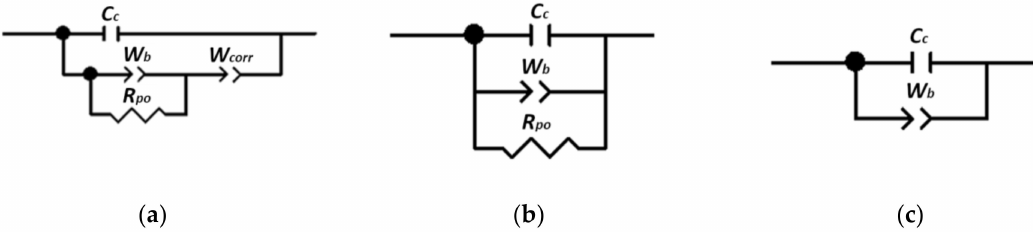
Figure 1. Equivalent circuits used for analysis of EIS data (models a , b and c ). C c , W b , R po and W corr , represent the coating capacitance, the Warburg di ff usion through the coating, the resistance of conductive paths through the electrolyte-filled coating pores and the Warburg coe ffi cient for a di ff usion-controlled corrosion process (see Equations (1)–(4)),